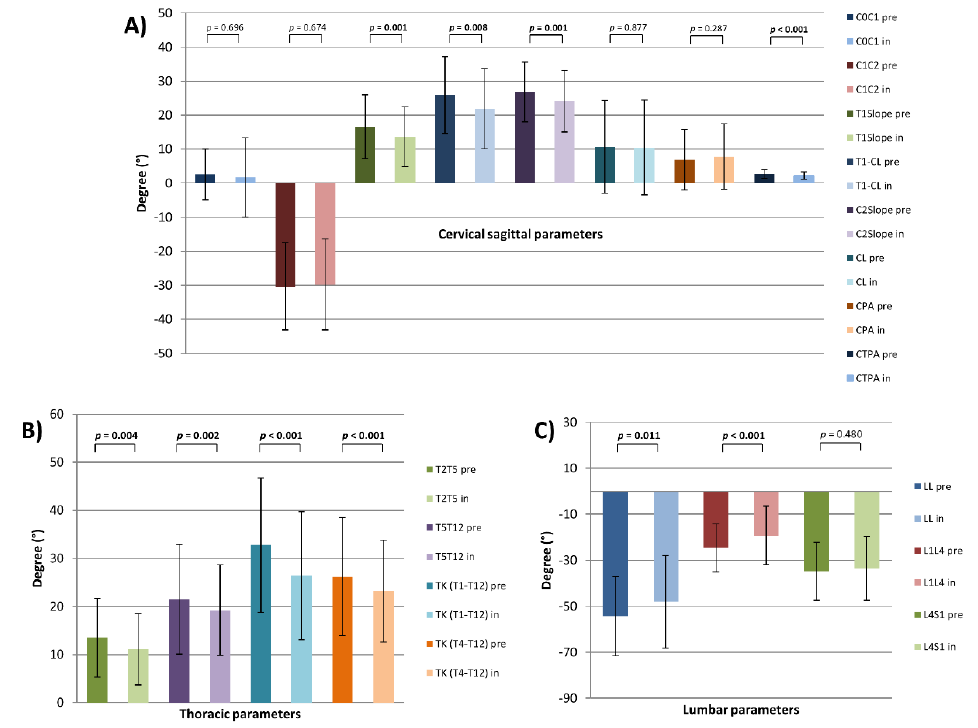
Figure 4. Sagittal plane parameters of cervical ( A ), thoracic ( B ) and lumbar ( C ) spine for all patients (pre- and in-brace); p = statistical significance, p < 0.05.